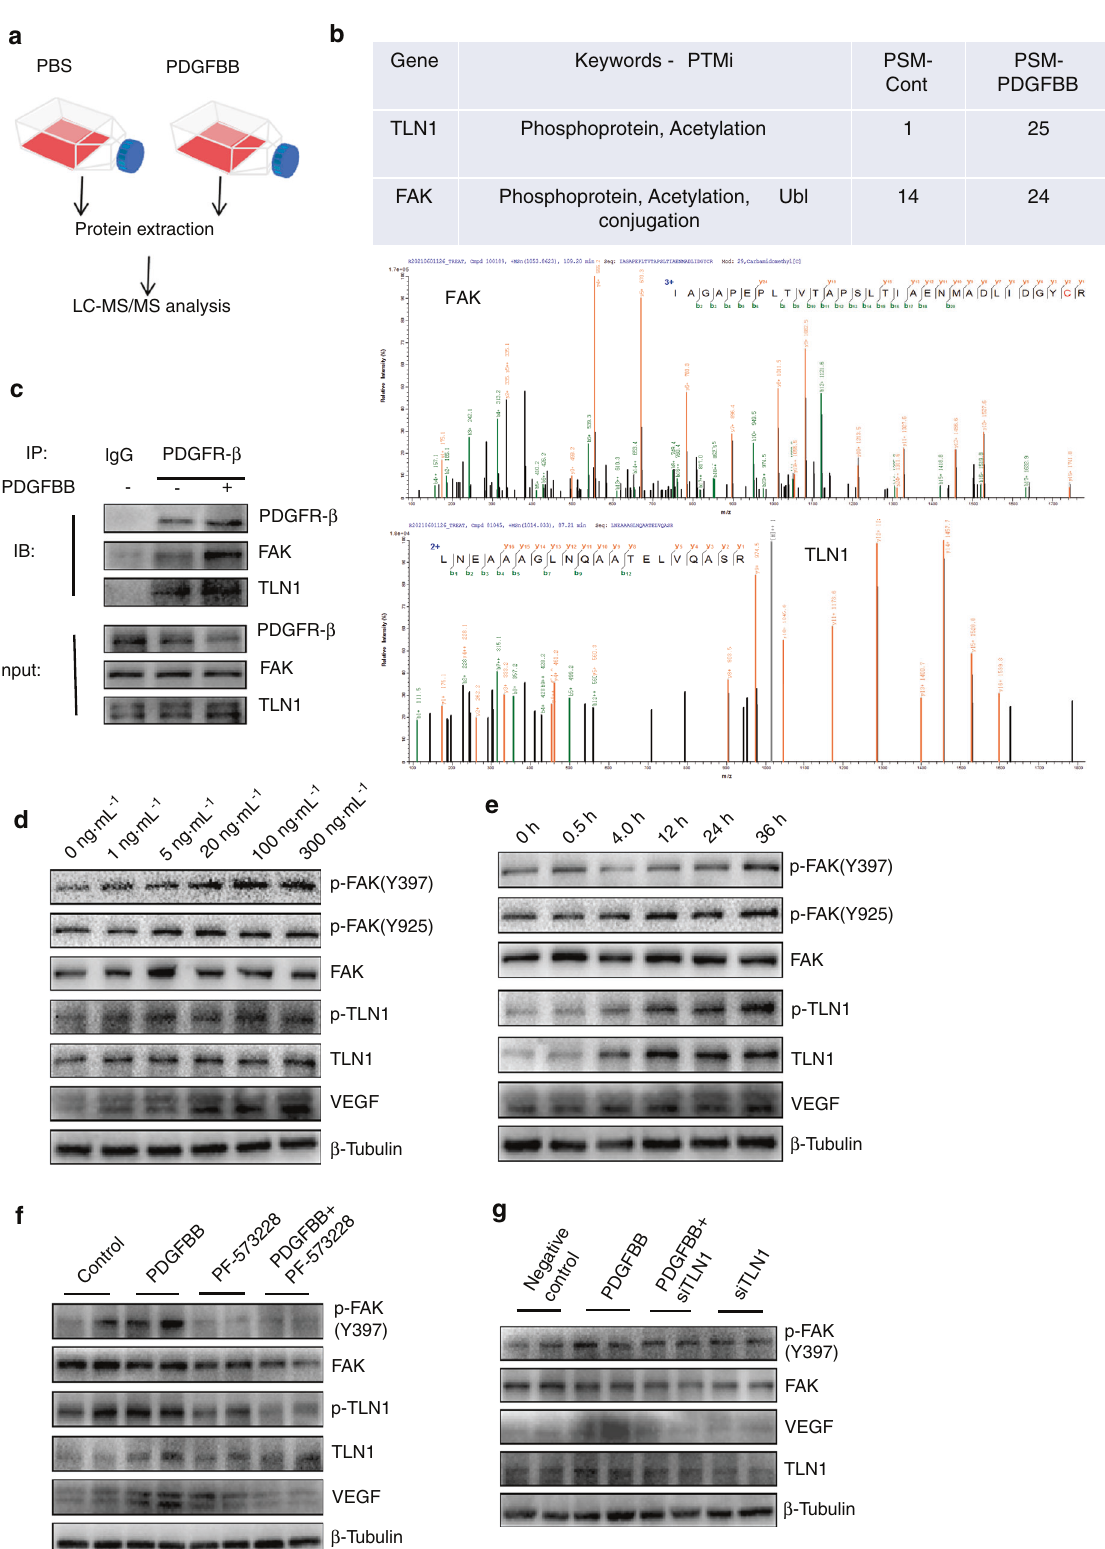
Fig. 5 PDGFR- β interacts with FAK and TLN1 in ECs. a Strategy for identifying PDGFR- β binding proteins using LC-MS/MS analysis. Bone morrow endothelial cells (BMECs) treated with PDGF-BB (300ng·mL − 1 ) for 24h were subjected to immunoprecipitation (IP) with an antibody against PDGFR- β followed by LC-MS/MS analysis. b The PDGFR- β binding proteins FAK and TLN1 were identi fi ed with LC-MS/MS analysis. c PDGFR- β was immunoprecipitated from BMECs with an anti-PDGFR- β antibody. The presence of FAK, TLN1, and PDGFR- β in these immunoprecipitates was evaluated with immunoblotting. Western blot analysis of FAK, TLN1, and VEGF in the BMECs treated with different PDGF-BB doses (0-300ng·mL − 1 ) ( d ) or for different times at 0h – 36h ( e ). Western blot analysis of FAK, TLN1, and VEGF in the BMECs treated with FAK inhibitors ( f ) or TLN1 siRNA ( g